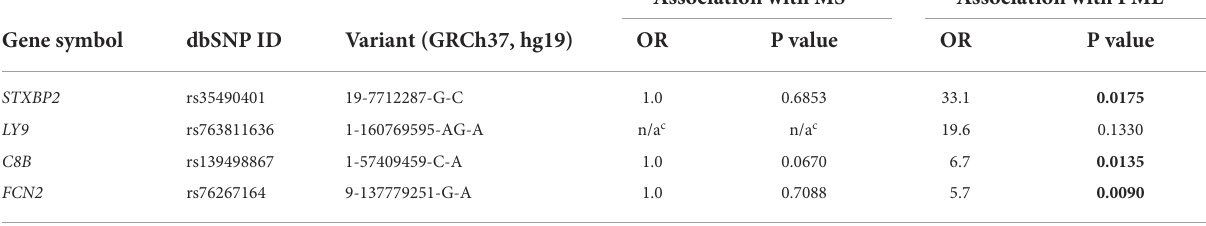
TABLE 4 PML risk variant association with MS vs. drug-exposed PML cases.